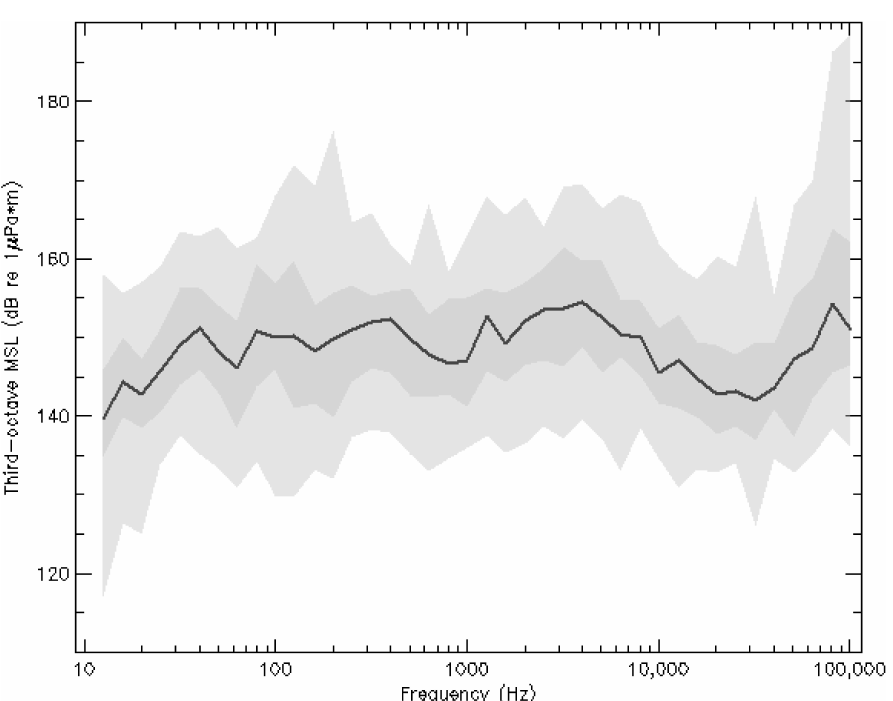
Figure 5. In black, median MSLs spectrum of the 45 events discussed in this work following 1/3-octave band integration. In grey and light grey are shown respectively the 25–75% and 5–95% percentile envelopes.